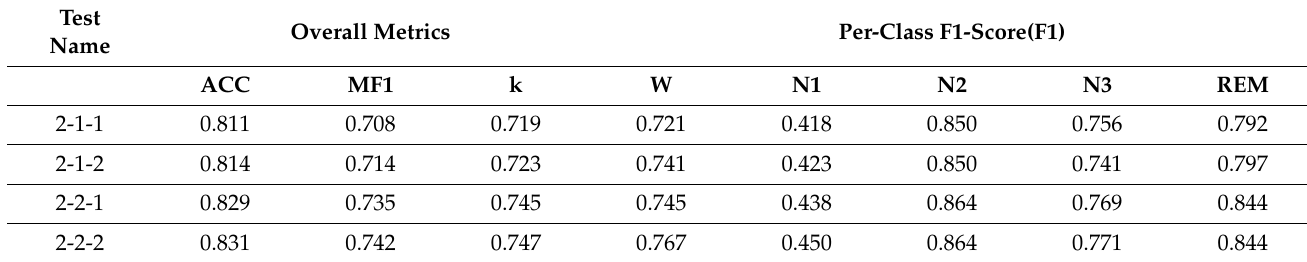
Table 4. Classification results of training with augmented data and augmented sequence.